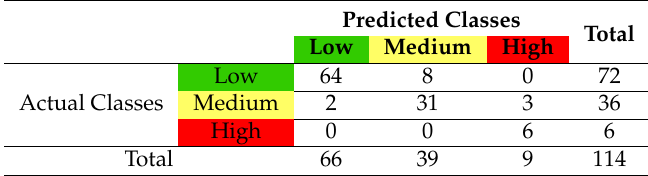
Table 5. The 3-class contingency table for the railway stations of Abruzzo.